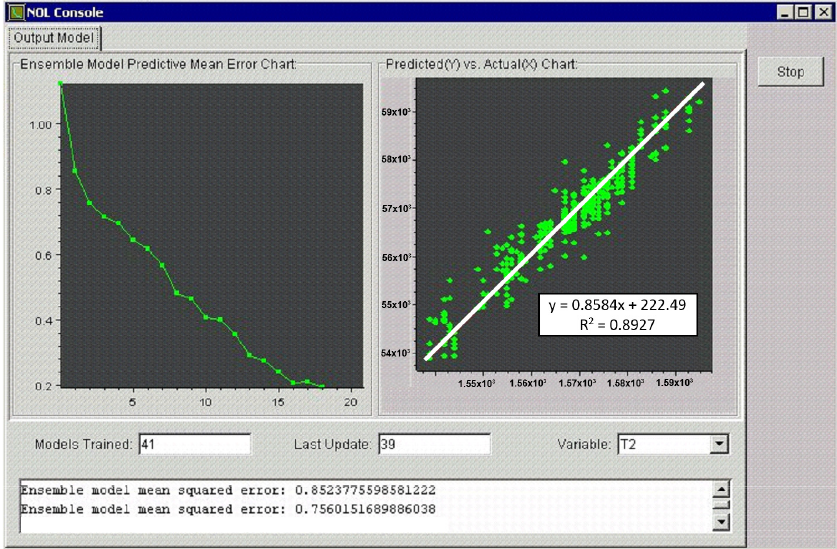
Figure 11. Neural network training progress.